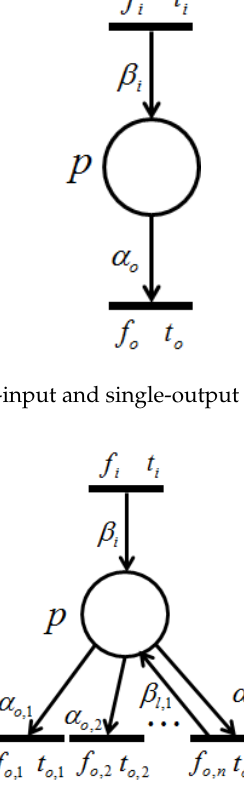
Figure 8. Conflict structure ( PN conf